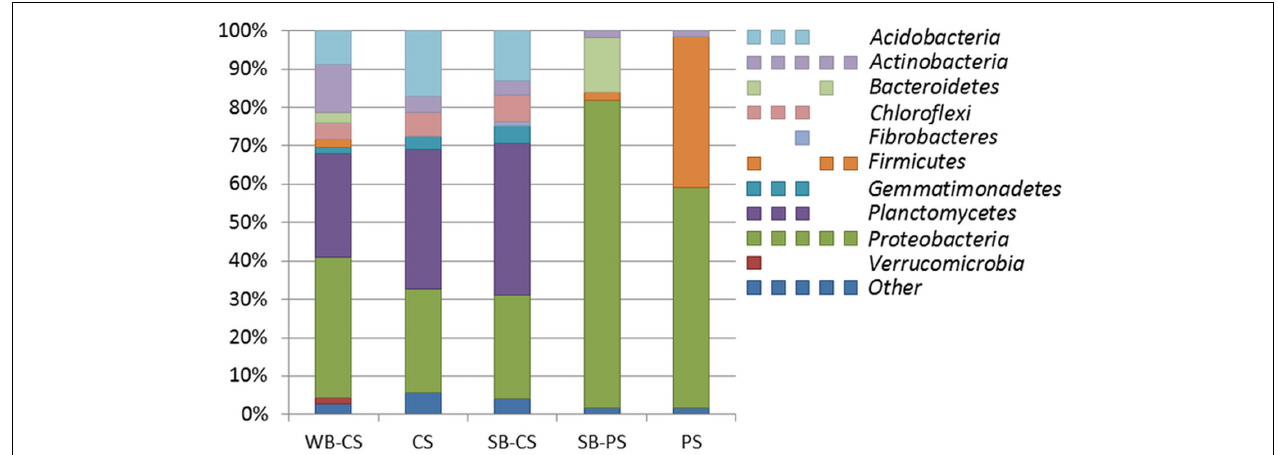
FIGURE 2 | The structure of bacterial communities at phylum level of wild beetrhizosphere(WB-CS),coastaldriftlinebulksoil(CS),sugarbeetplants cultivated in coastal drift line soil (SB-CS), sugar beet plants cultivated in potting soil (SB-PS), and potting bulk soil (PS). Relative composition of